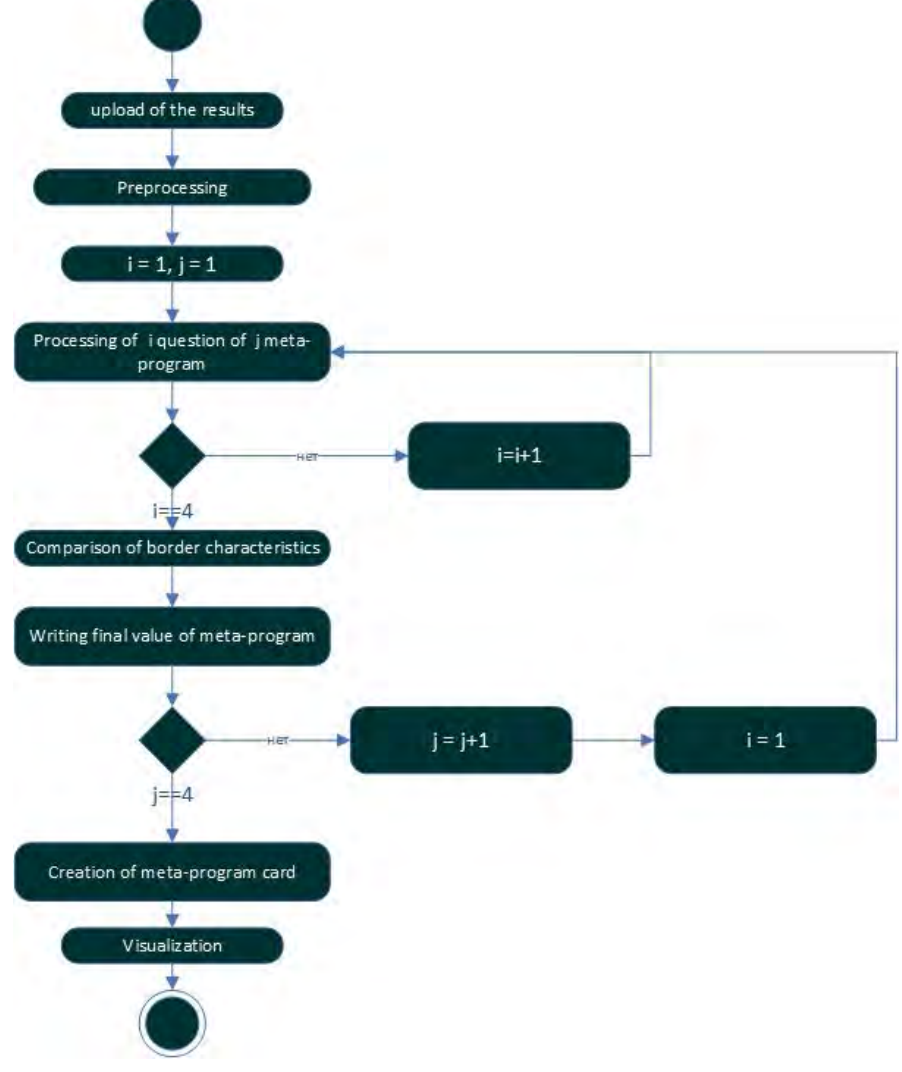
Fig. 2  Algorithm of processing